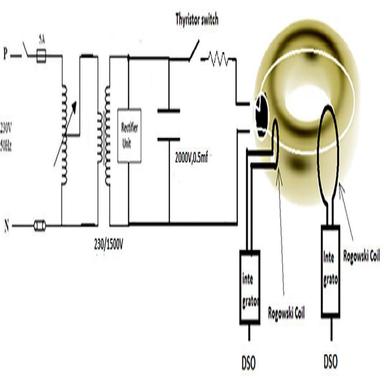
Experimental test set-up.